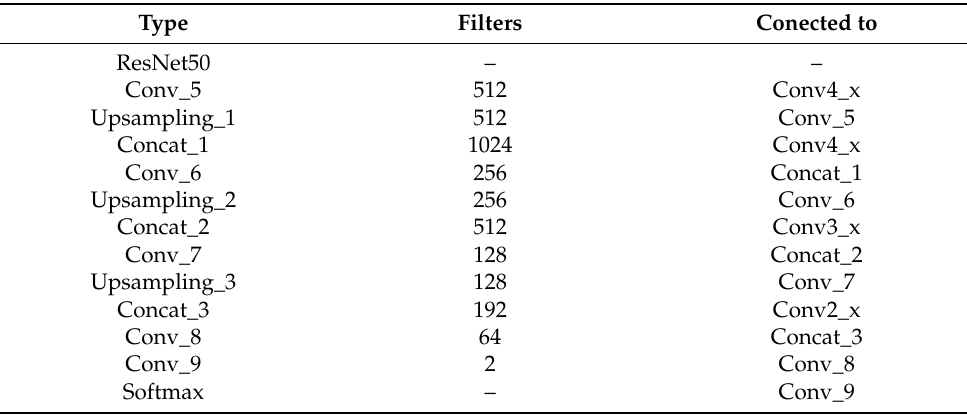
Figure 12. Architecture of the ResNet50+U-Net. Table 6. Layer description of the